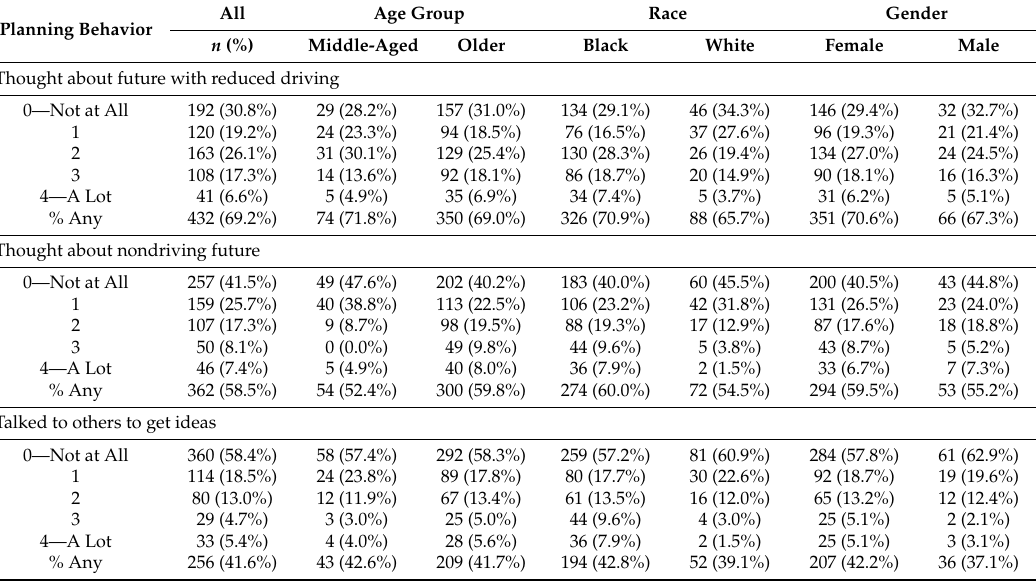
Table 4. Drivers’ Planning Behaviors for Future Transportation